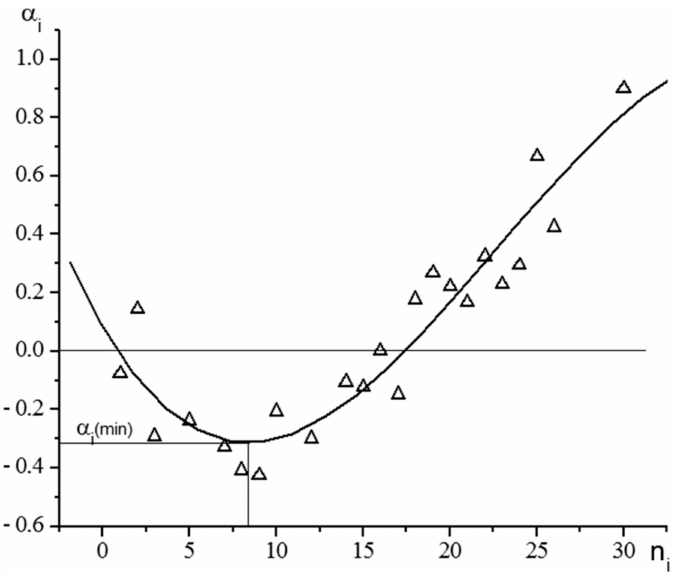
Figure 5. Growth increment of azimuthal non-uniformities (as dependent on the mode number n for an underexpanded jet discharged from a convergent nozzle (M a = 1) with n p = 4.75 [37] (with permission of redaction of Journal Thermophysics and